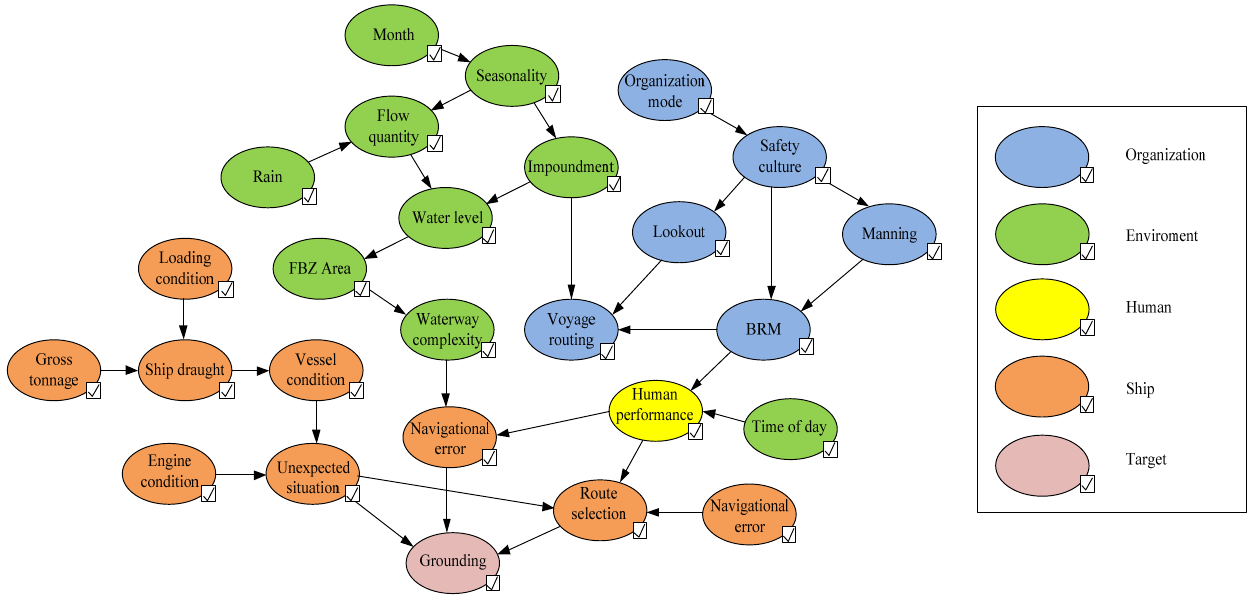
Figure 3. Bayesian Network to estimate grounding probability.